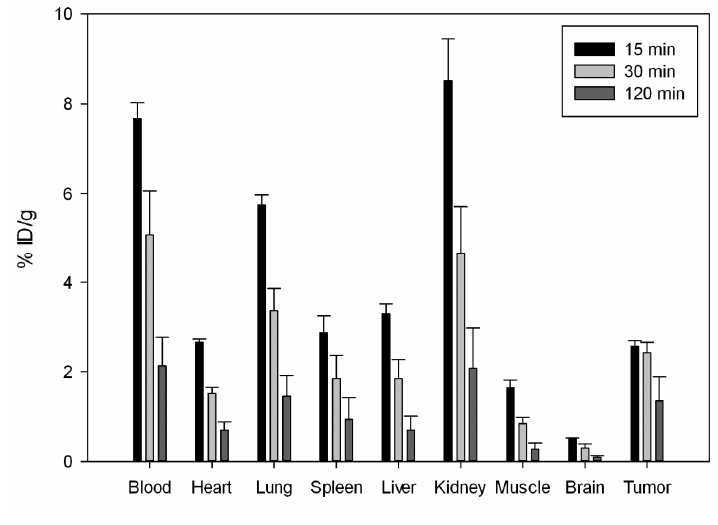
Figure 12. Organ distribution experiments of 131 I-labeled CaIX-P1 in Balb/c nu/nu mice, carrying HCT116 tumors (3 animals per experiment).